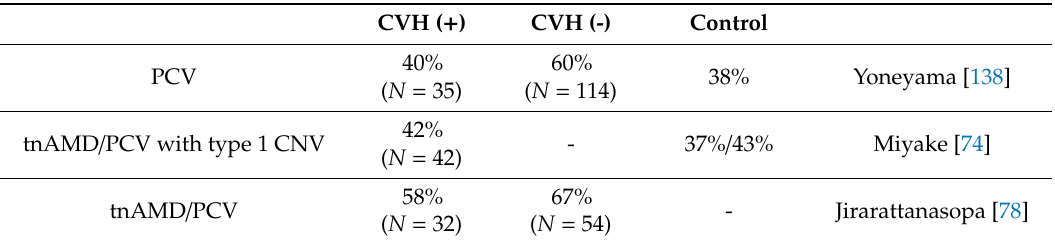
Table 3. Risk allele frequencies of ARMS2 A69S in Japanese patients with age-related macular degeneration.